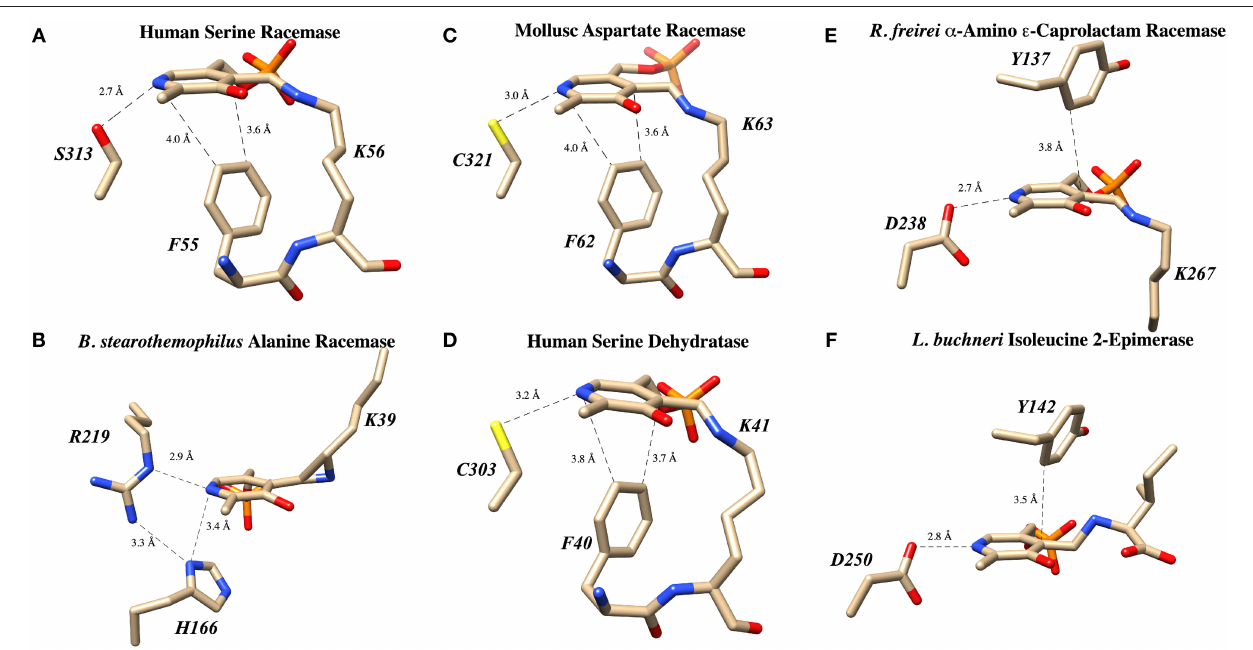
FIGURE 6 | PLP binding sites in known racemase structures illustrating hydrogen bonding and π -facial interactions of the pyridine ring. (A) hSR: pyridine H-bonding with S313 and edge-to-face π - π interaction with F55 (PDB code: 3L6B). (B) Alanine racemase: presumably weak pyridine H-bonding with R219 (PDB code: 1SFT). (C) Aspartate racemase: pyridine H-bonding with C321 and edge-to-face π - π interaction with F62 (PDB code: 5YBW). (D) Human serine dehydratase: pyridine H-bonding with C303 and edge-to-face π - π interaction with F40 (PDB code: 4H27). (E) α -Amino ε -caprolactam racemase: pyridine H-bonding with D238 and edge-to-face π - π interaction with Y137 (PDB code: 5M46). (F) Isoleucine 2-epimerase: pyridine H-bonding with D250 and edge-to-face π - π interaction with Y142 PDB code: